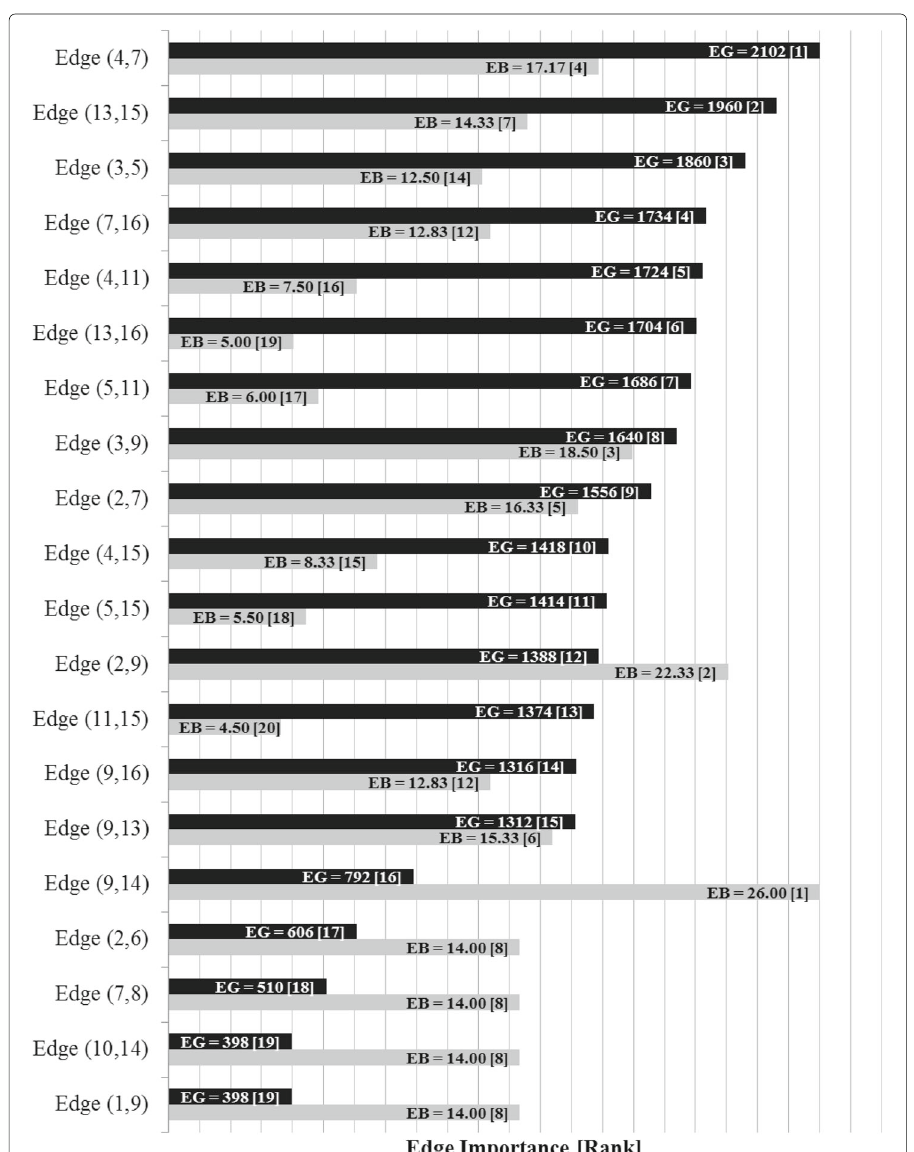
Fig. 14 Edge Gravity (EG) and Edge Betweenness (EB) solutions for Florentine families network